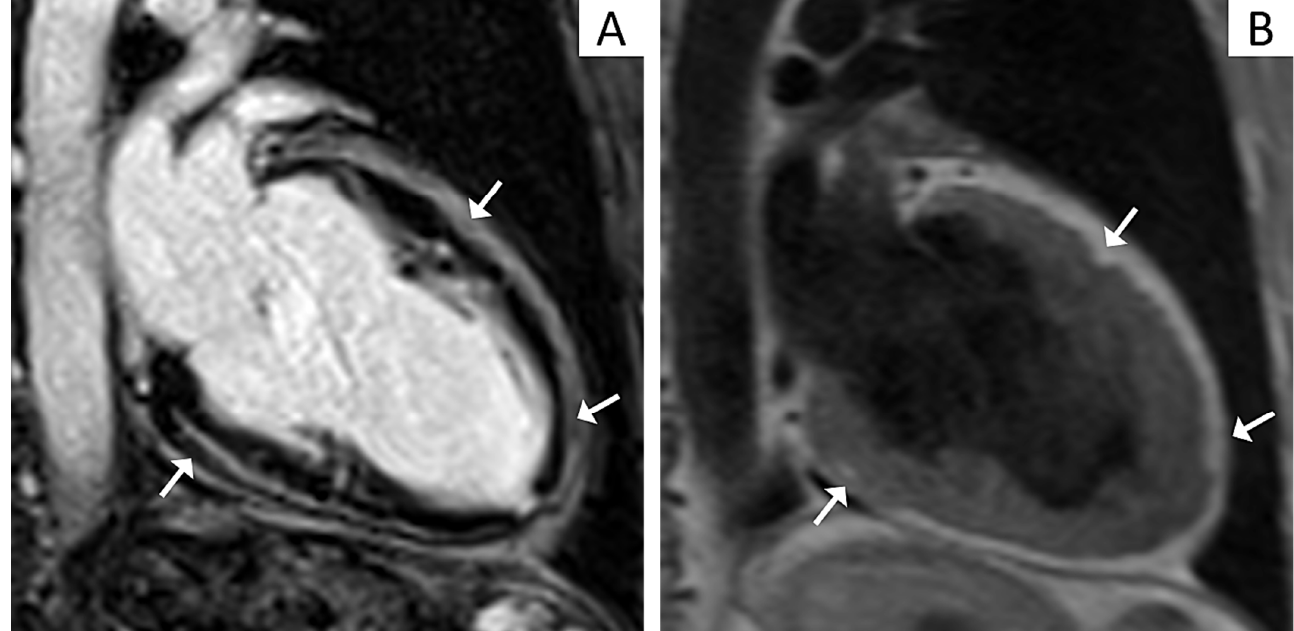
Figure 2. Cardiac magnetic resonance (CMR) imaging features of a patient affected by left-dominant arrhythmogenic cardiomyopathy. Post contrast CMR images in two-chamber view showing extensive late gadolinium enhancement in the form of stria proceeding from the epicardium towards the endocardium in the inferior and anterior walls (Panel A , arrows). T1 weighted CMR sequences in two-chamber view evidencing fatty infiltration in the same regions as in Panel A (Panel B , arrows).